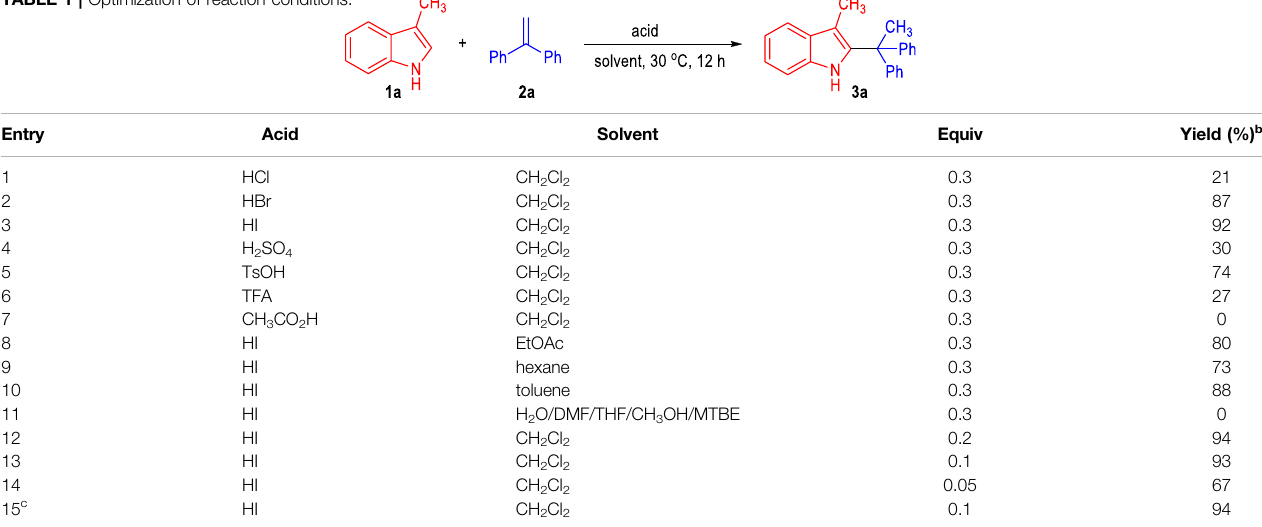
TABLE 1 | Optimization of reaction conditions.